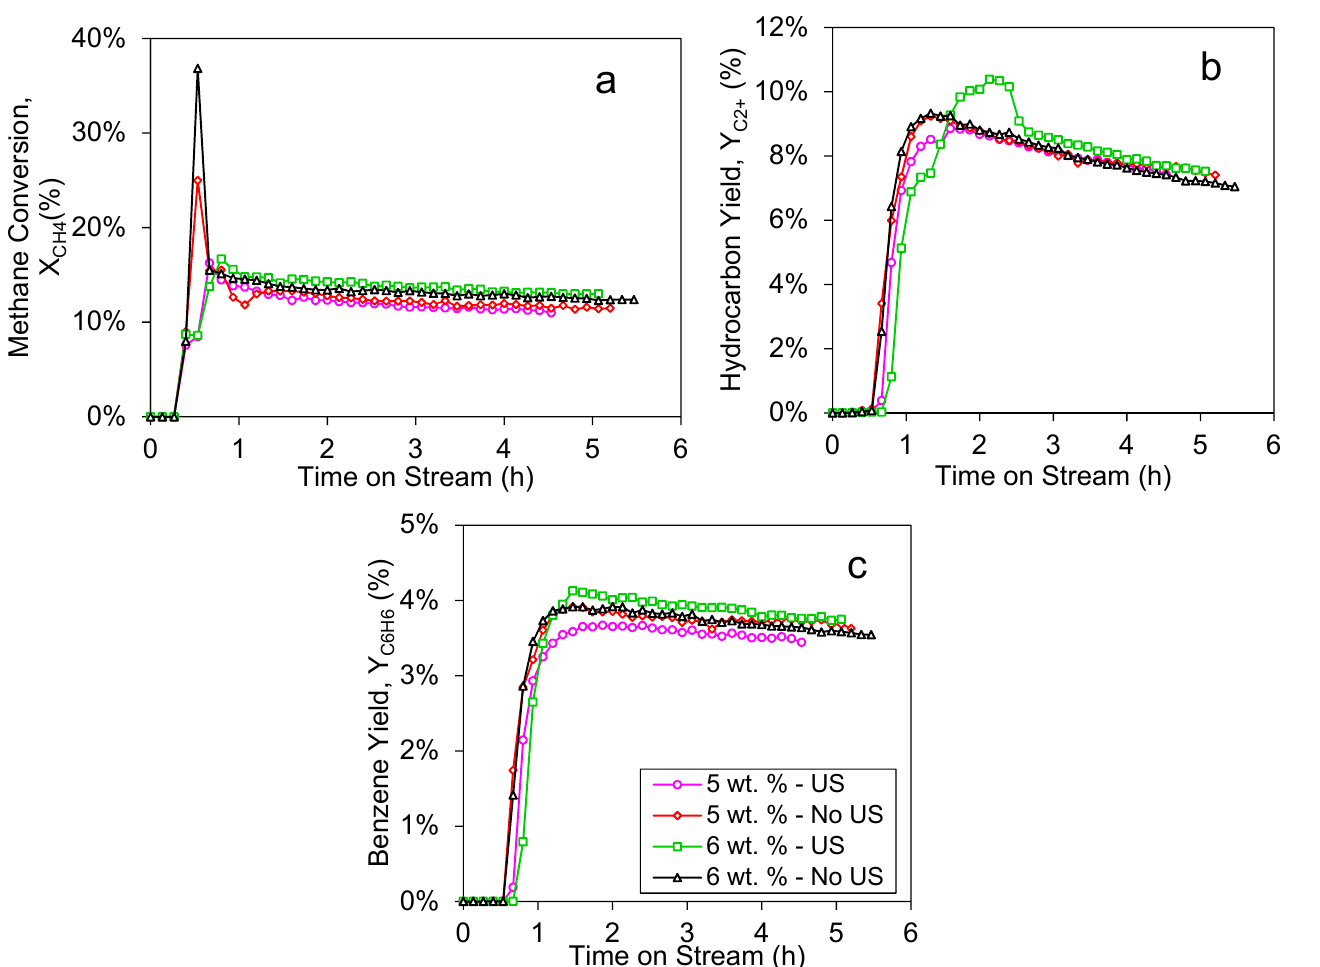
Table 3. Catalytic activity of the Mo/ZSM-5 catalysts prepared with and without ultrasound for non-oxidative methane dehydroaromatization after 4 h on stream.